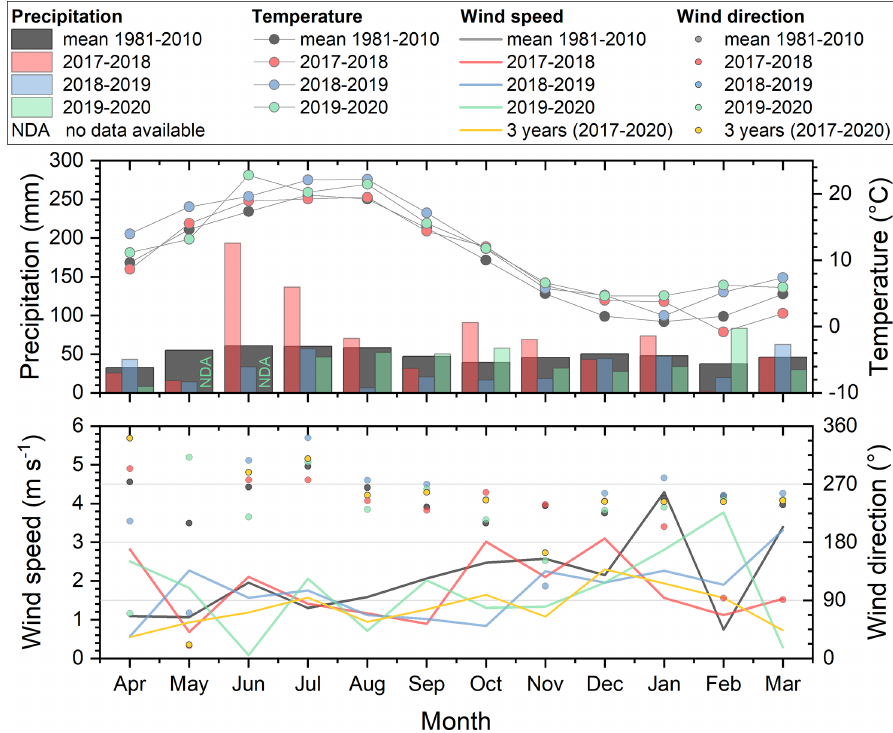
Figure 2. Meteorological data such as temperature, precipitation, wind speed, and wind direction from the German Weather Service station Berlin Tempelhof (German Weather Service site ID: 433) located 7km south-east of the flux site.